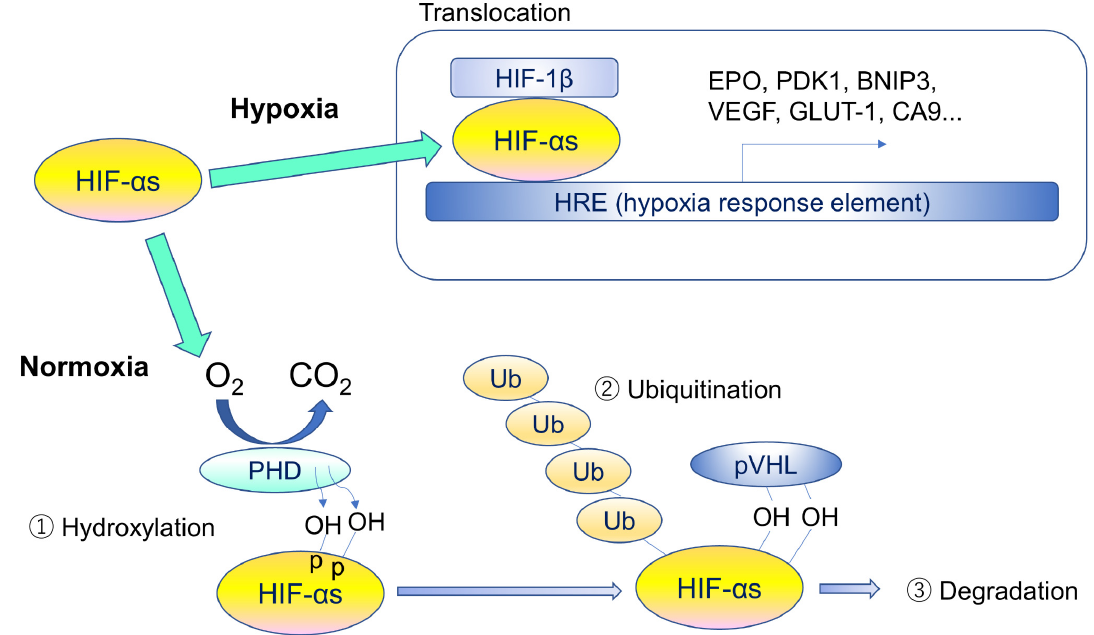
Figure 3. Regulatory mechanism of hypoxia-inducible factors. Under hypoxia, HIF- α s translocate into the nucleus, form heterodimers with β -subunits, and promote transcription of HIF target genes by binding to hypoxia response element (HRE). Under normoxia, specific proline residues of HIF- α s are hydroxylated by prolyl hydroxylase (PHD) (1), and the hydroxylated HIF- α s are ubiquitinated by ubiquitin ligase containing pVHL (2) and degraded by proteasome (3). HIF- α s stands for different forms or multiple α